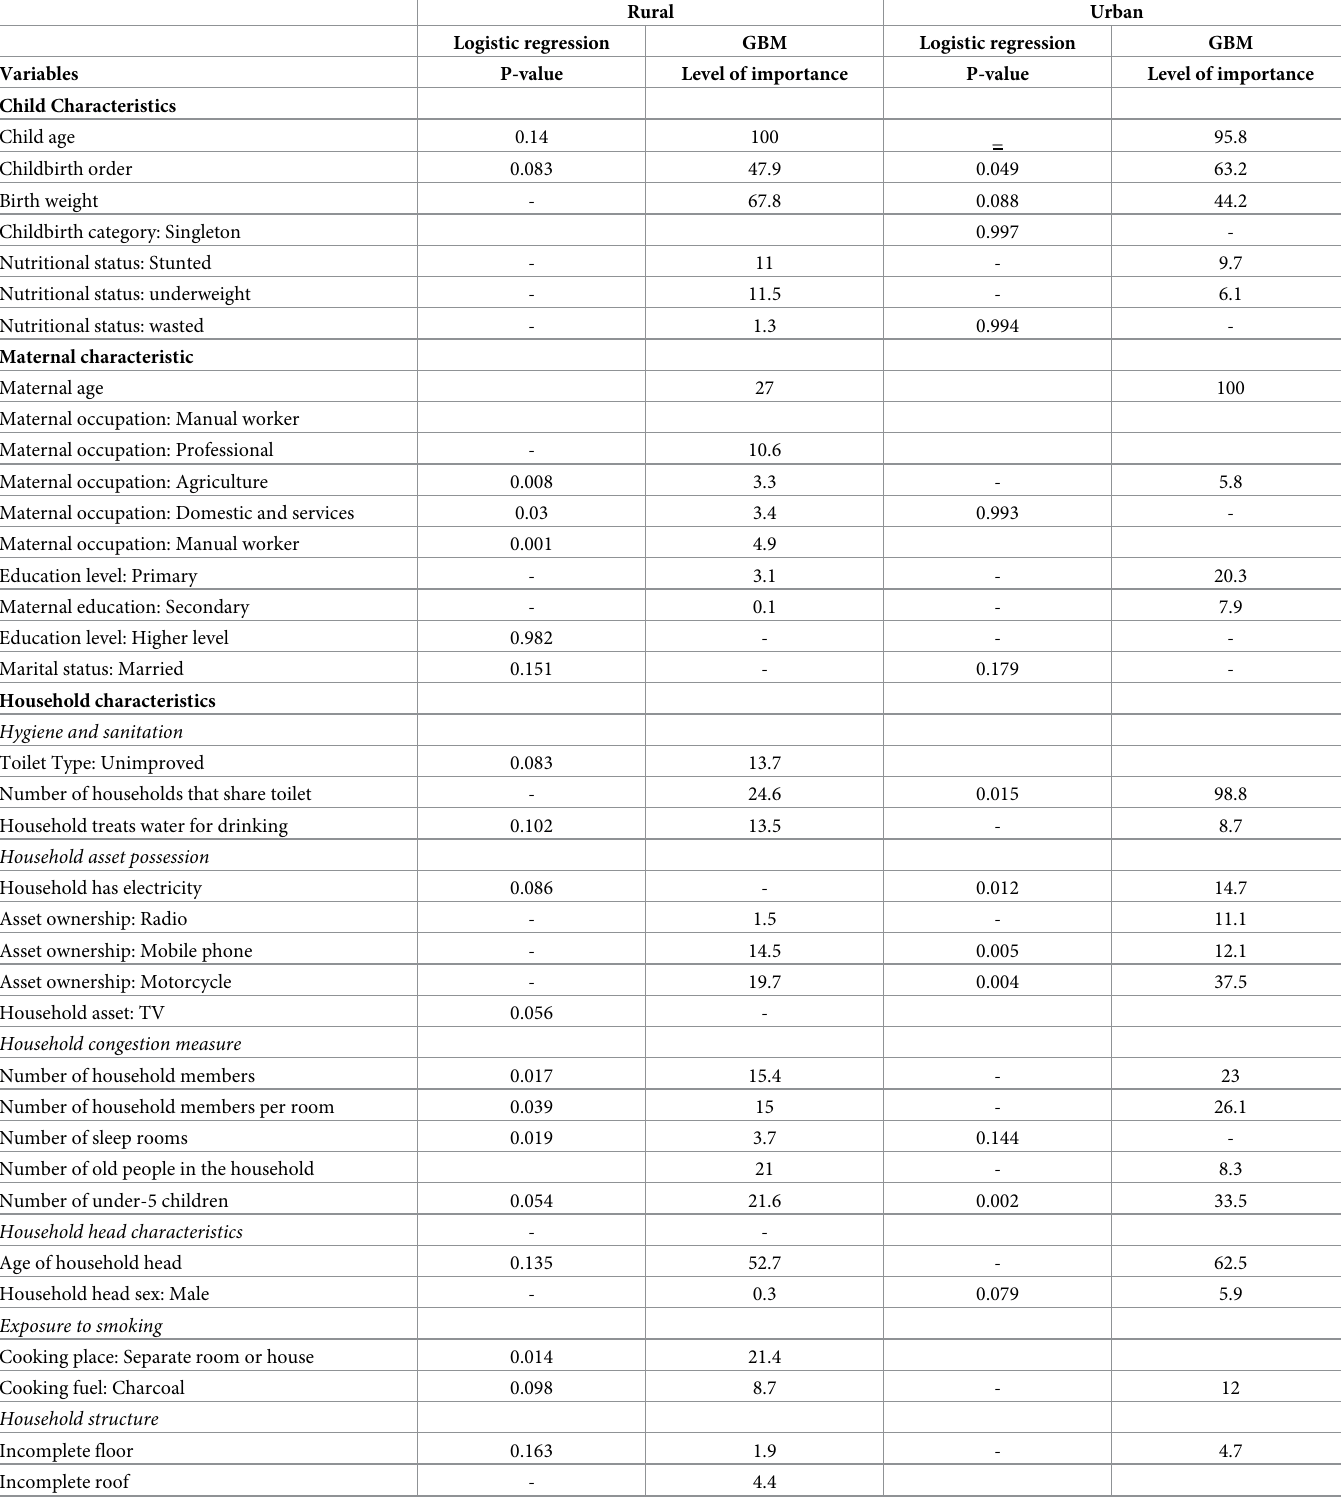
Table 5. Differences in identified predictors of ARI in traditional logistic regression and GBM. Rural Urban Logistic regression